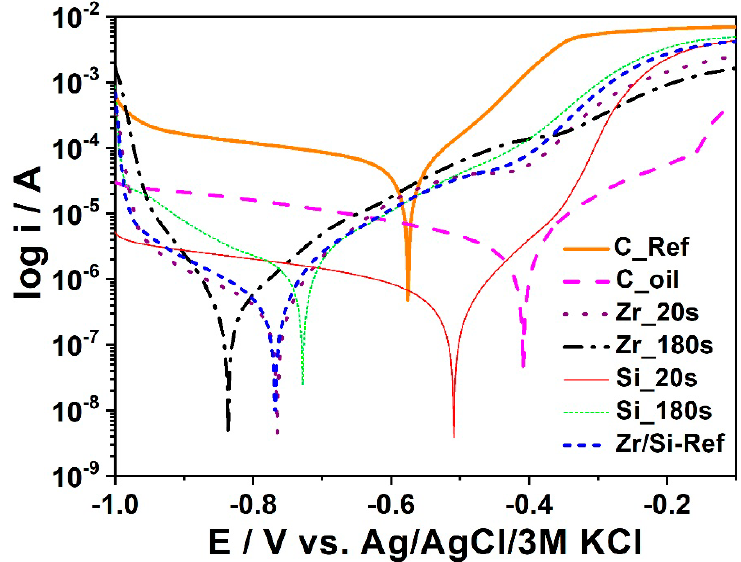
Figure 18. Polarization curves obtained of the Zr_20s, Si_20s, Zr_180s, Si_180s, Si_Ref, Zr_Ref, C_Ref, and C_Oil samples.